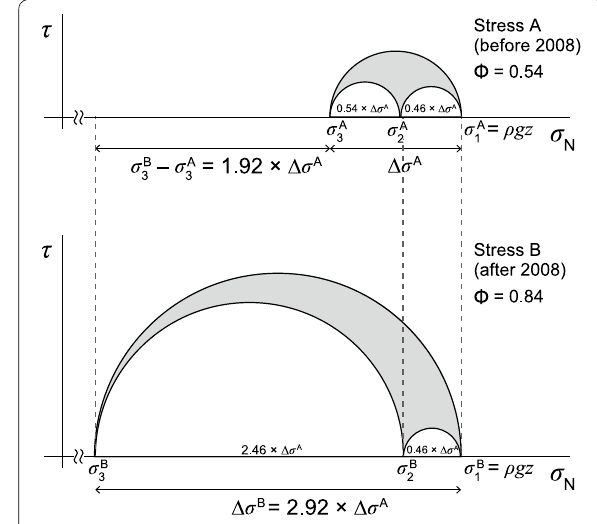
Fig. 6 Mohr circle representations of the state of stress for stress A (upper plot) and stress B (lower plot) for the extension associated with the co- and post-seismic deformations of the M7 class earth- quakes. ρ is density, g is gravitational acceleration, z is depth, and Δ σ A and Δ σ B show the differential stress for stresses A and B,